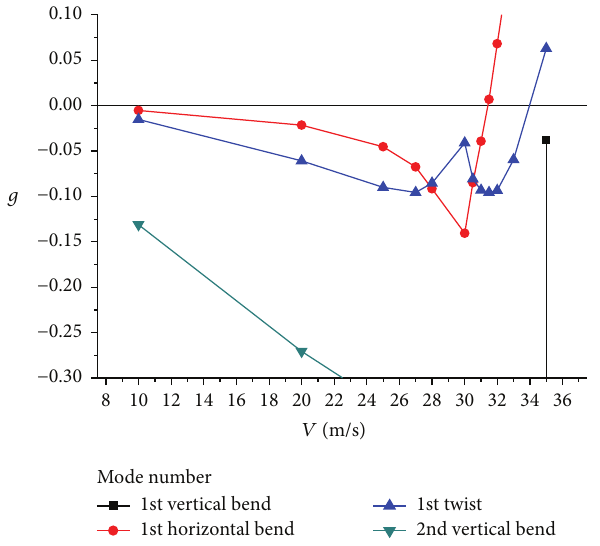
Figure 21: Accurate data pieced together roughly.